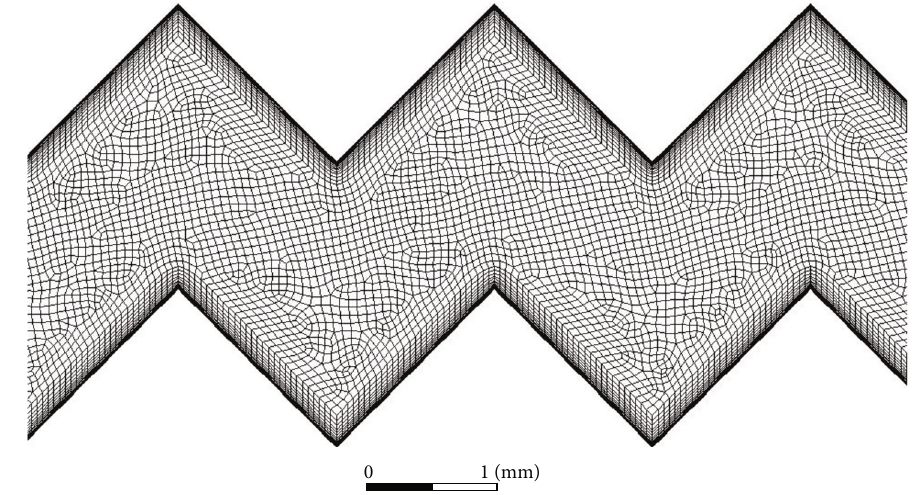
Figure 4: Grids of the rough